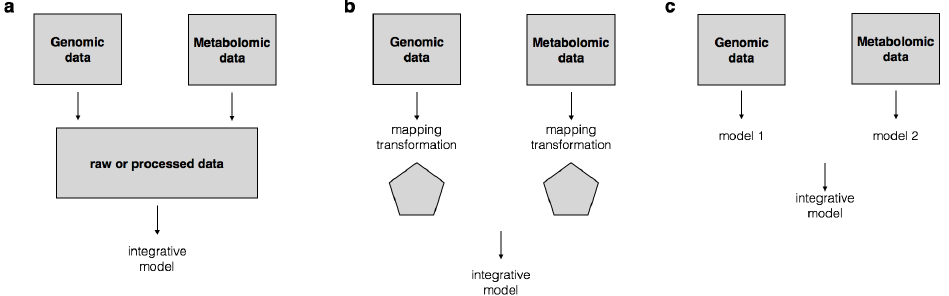
Figure 3. Different data integration strategies. ( a ) illustrates early integration where data is com- bined into a single data matrix before modeling. ( b ) depicts the intermediate data integration level where data matrices are transformed or mapped into a common meaningful representation before modeling. In ( c ), each data model is generated separately and is then combined with models based on other data types to generate the integrative or high-level model. Early integration is often used in meta-analysis [76]. Intermediate and late data integration strategies can be applied for meta-analysis but such applications are scarce in the